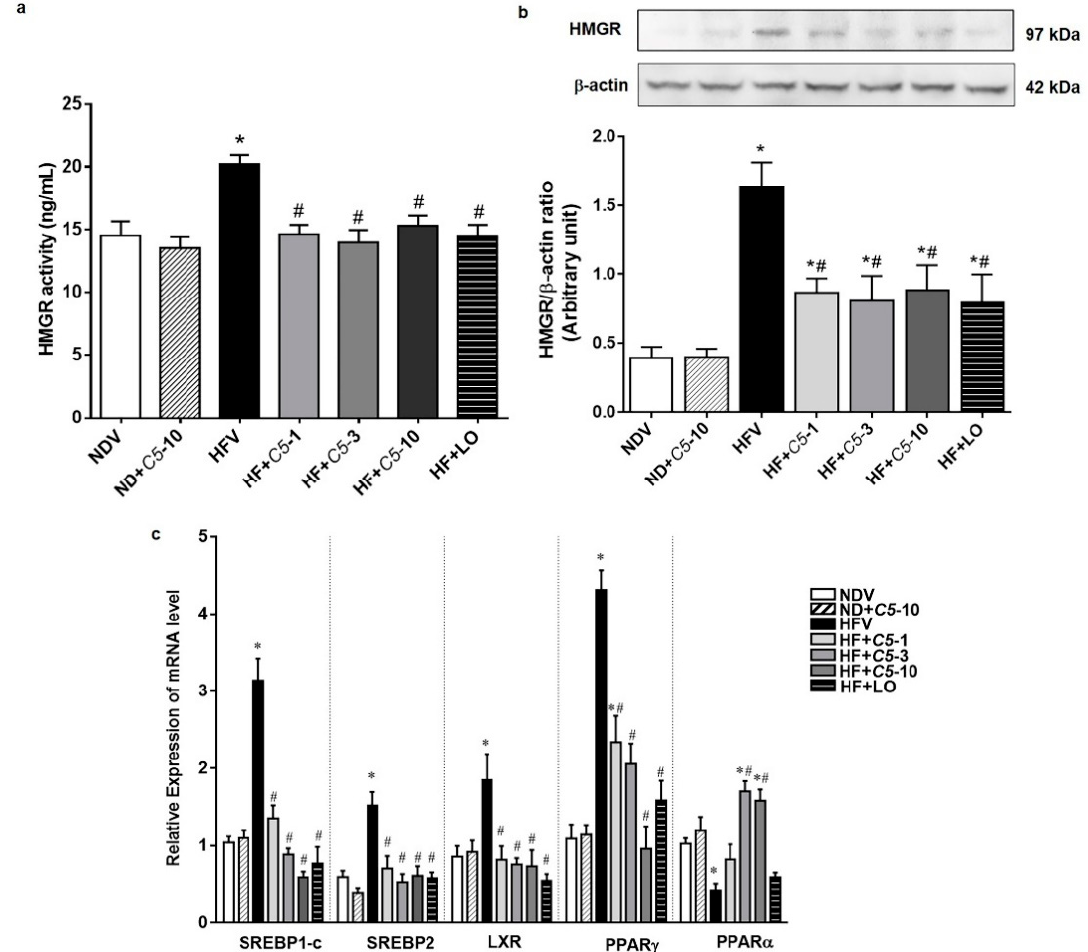
Figure 4. Effect of α , β -dehydromonacolin S ( C5 ) on lipid metabolism. ( a ) HMGR activity was determined from liver tissue using ELISA kit. Values are mean ± S.E.M ( n = 6), ( b ) HMGR protein expression extracted from rat liver tissue was analyzed by Western blotting. A representative blot of HMGR protein expression is shown on the top panel and quantification of relative protein expression in each experimental group presented on the bottom. Anti- β -actin antibody was used as loading control. Values are mean ± S.E.M ( n = 5), and ( c ) mRNA expression of SREBP-1c, LXR α , PPAR γ , SREBP2 and PPAR α from each experimental group were compared using qPCR. Each data is expressed as mean ± S.E.M ( n = 5). * p < 0.05 represents the significant difference compared with the NDV group and # p < 0.05 represents the significant difference compared with the HFV group.